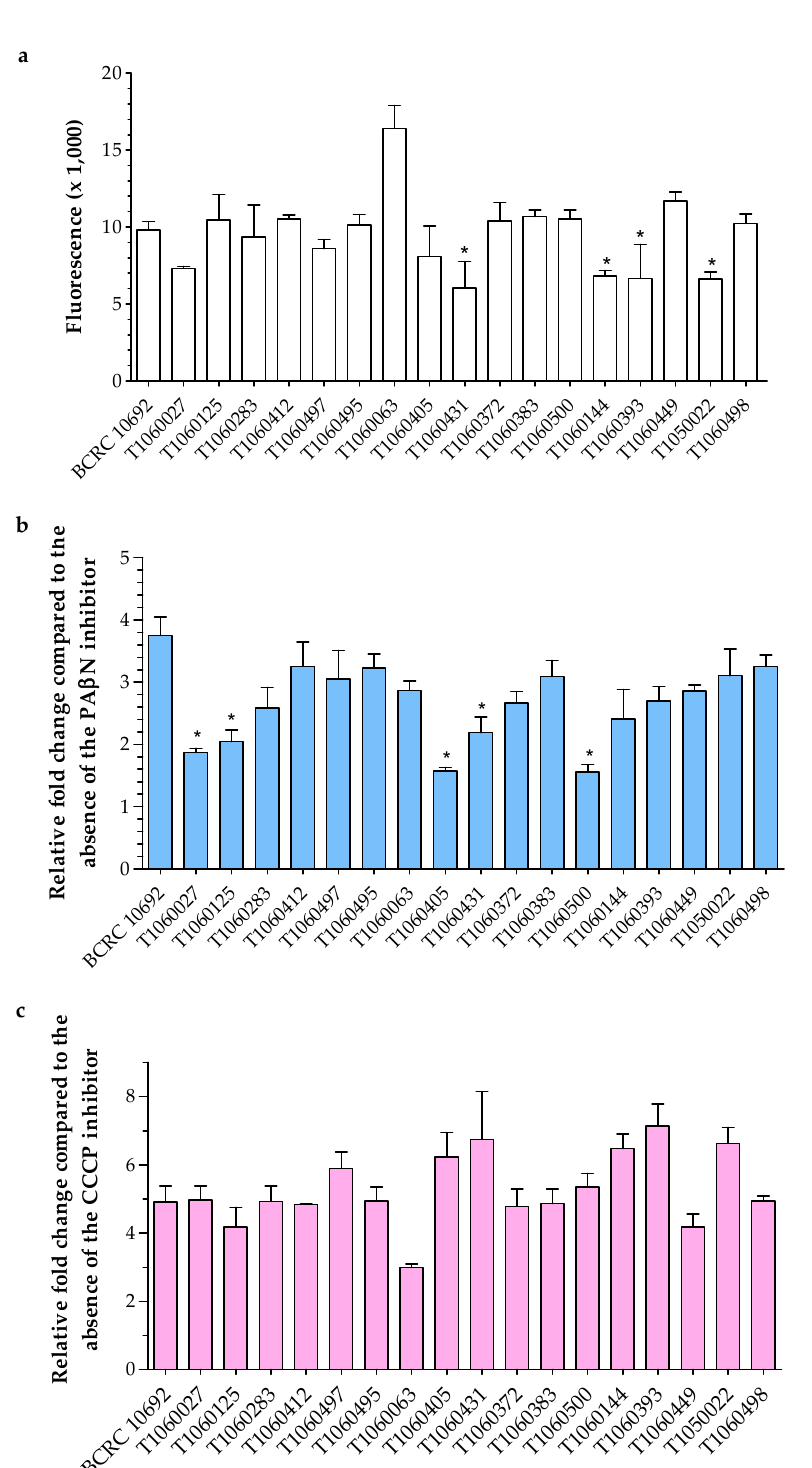
Figure 3. Membrane permeability by using fluorescence dye (Hoechst 33342) accumulation in the absence and presence of the efflux pump inhibitors (EIs) PA β N and CCCP. ( a ) Fluorescence values of each isolate were detected in the absence of EIs. ( b ) and ( c ) Fold changes in each isolate were calculated from the fluorescence values in the presence of individual EIs divided into those in the absence of EIs. The asterisk (*) indicates a significant difference compared to the reference BCRC 10692 ( p ≤